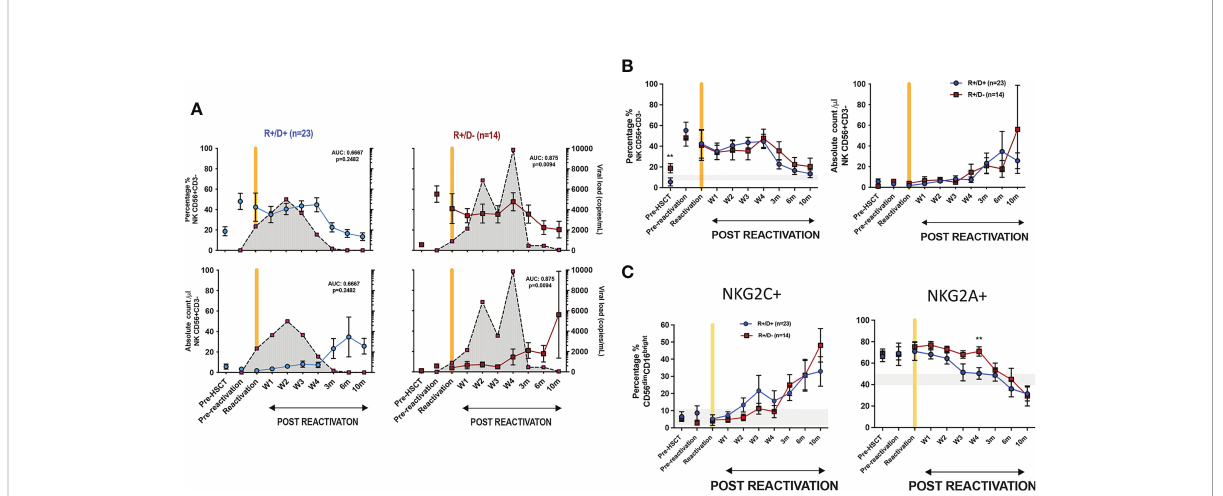
FIGURE 4 In fl uence of CMV serostatus of transplant donor on the kinetics of viral load at reactivation and subsequent pro fi le of NK cells. (A) Viral load and NK cell percentage and number following CMV reactivation in relation to CMV serostatus of donor (positive; D+ or negative; D-). Grey shading represents aggregate pro fi le of CMV viral load over time. (B) Comparison of percentage and number of NK cells following CMV reactivation in relation to donor serostatus (R+/D+ in blue line and R+/D- in purple line). (C) Percentage of NKG2C+ (left) and NKG2A+ (right) NK cells following CMV reactivation in relation to donor serostatus (R+/D+ in blue line and R+/D- in purple line). Grey lines represent the range of NKG2C+ and NKG2A+ NK cells in healthy donors. (*p<0.05, **p<0.01, ***P<0.001; Wilcoxon sign rank test for matched